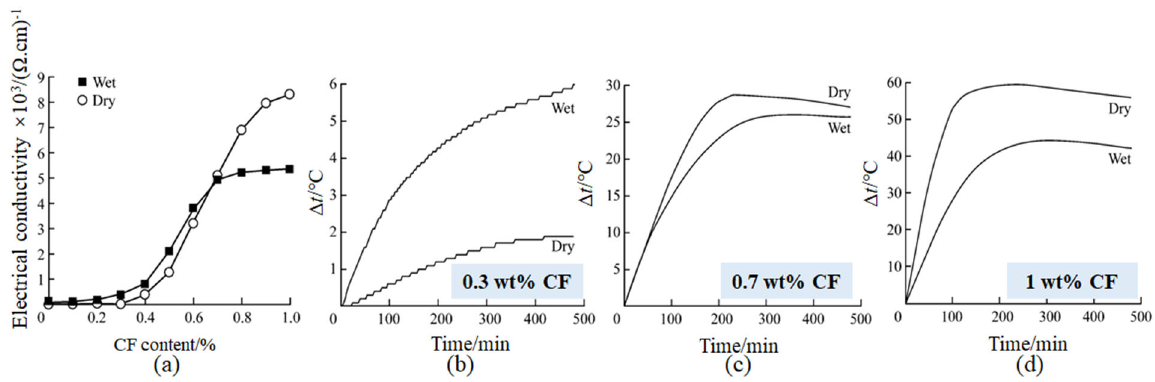
Figure 10. Variations in the ( a ) electrical conductivity and ( b – d ) electrothermal properties of CF content [101]. content